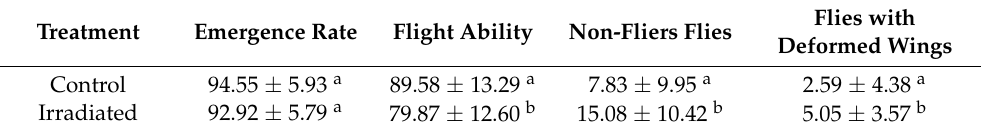
Flies with Deformed Wings